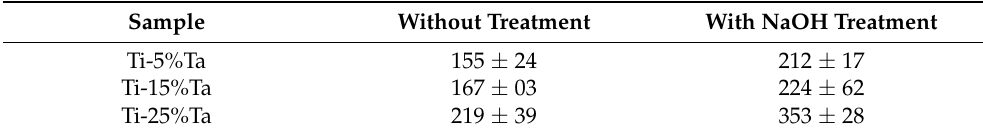
Table 2. Hardness measurements on Ti-xTa samples.